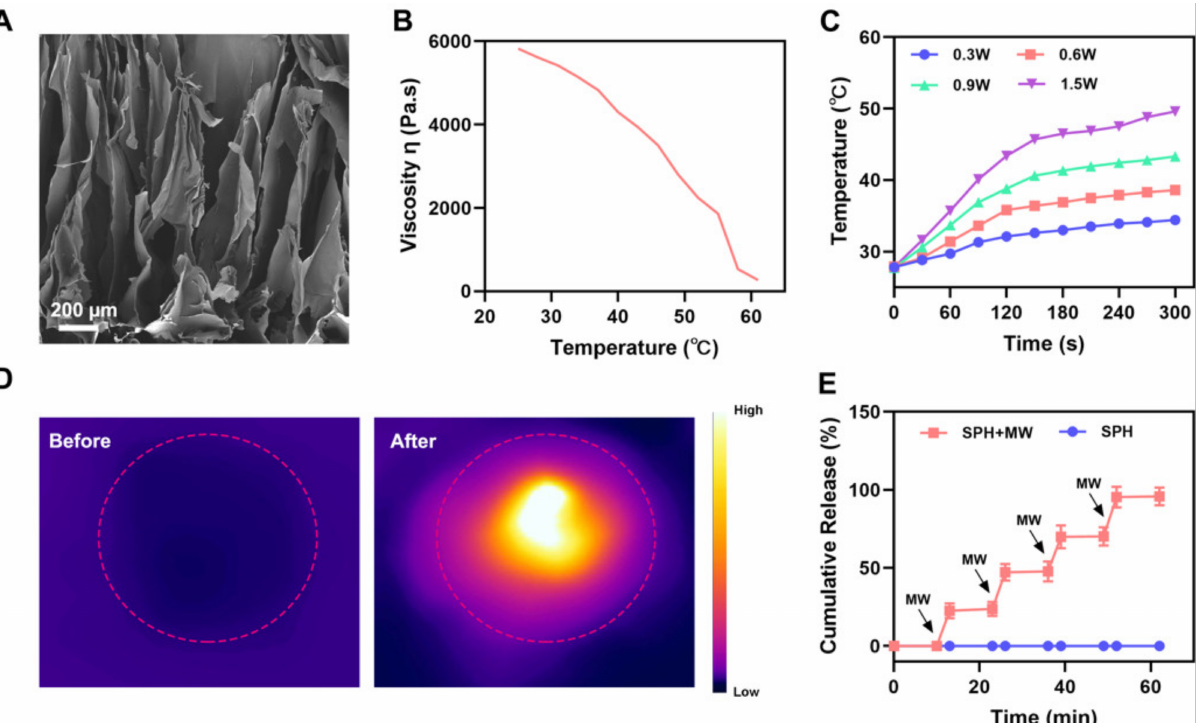
Figure 2. ( A ) Representative SEM images of SPH (containing 0.01 mg/mL SFN). ( B ) Viscosity measurements of reversibility for SPH during temperature jumps, from 25 ◦ C to 61 ◦ C. ( C ) Heating curves of SPH under varying powers of MW (containing 0.01 mg/mL SFN). ( D ) The infrared thermal images of the prepared SPH before and after MW treatment (MW power: 0.9 W). ( E ) The SFN release profile under different conditions; n = 3 (containing 0.01 mg/mL